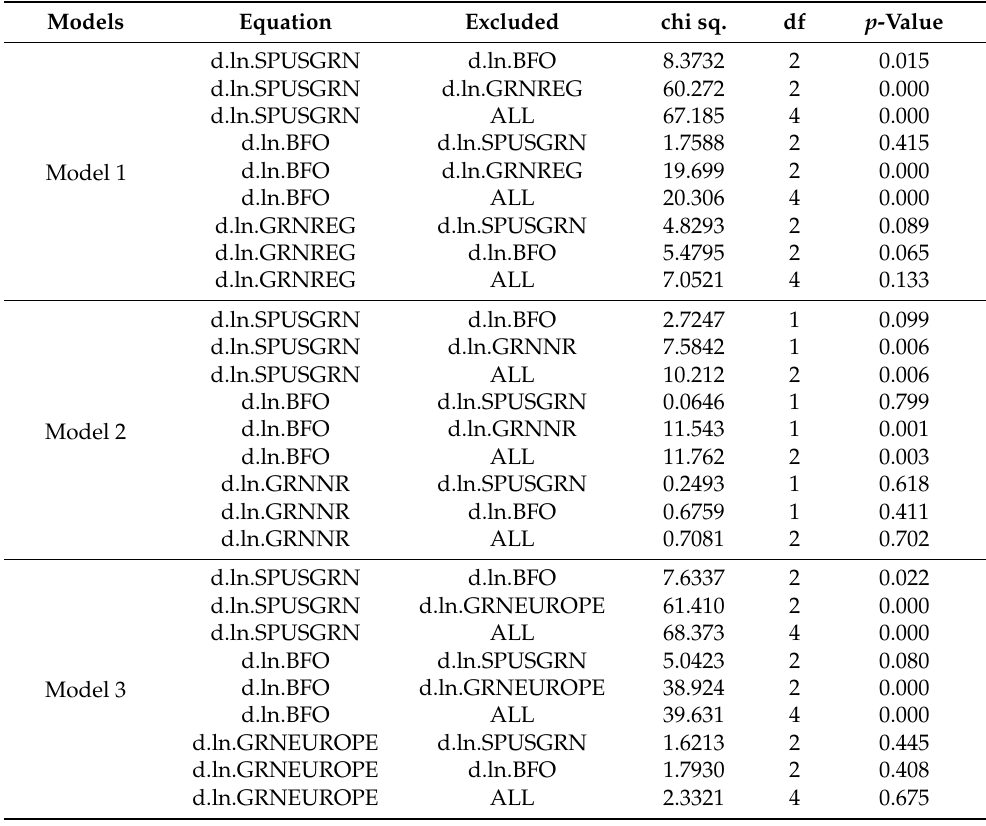
Table 7. The Granger causality tests for three models constructed on the basis of Equation (1).